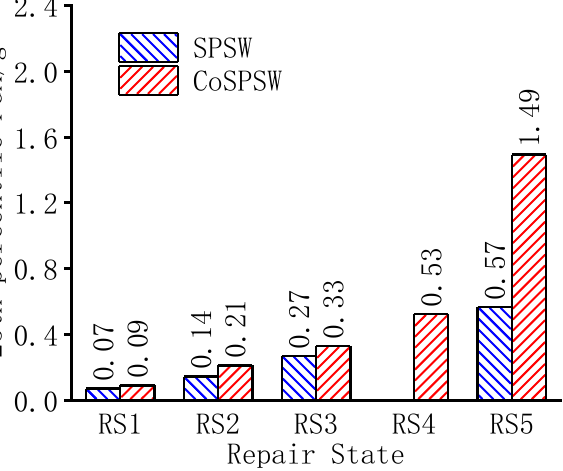
Figure 10. Acceleration-sensitive nonstructural components fragility curves: ( a ) CoSPSW, ( b ) SPSW.